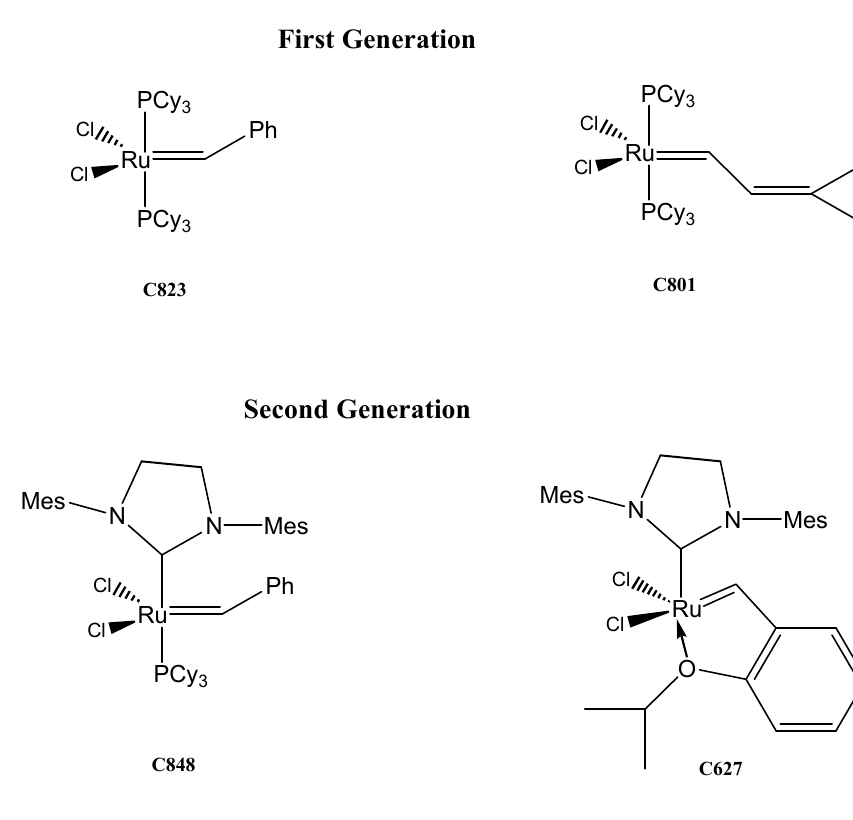
Figure 3. First- and second- generation of ruthenium-catalysts used for metathesis